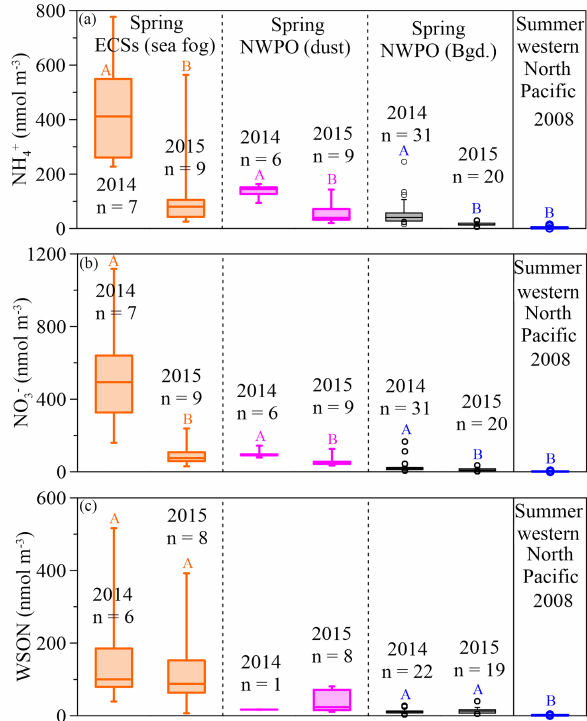
Figure 3. Box plots for spring concentrations of aerosol NH + (a) , 4 (b) and WSON (c) in the ECSs (the orange boxes denote NO − 3 sea-fog-modified aerosol) and NWPO (the pink boxes denote dust aerosol and the black boxes denote background aerosol), and sum- mer aerosol (the blue box denotes NH + and NO − from Miyazaki et 4 3 al. (2011) and Jung et al. (2013) and the WSON from Miyazaki et al., 2011). The large boxes represented the interquartile range from the 25th to 75th percentile, the line inside the box indicates the me- dian value, and the whiskers extend upward to the 90th and down- ward to the 10th percentiles. Significant differences at the p <0.05 level between different years are marked with coloured uppercase